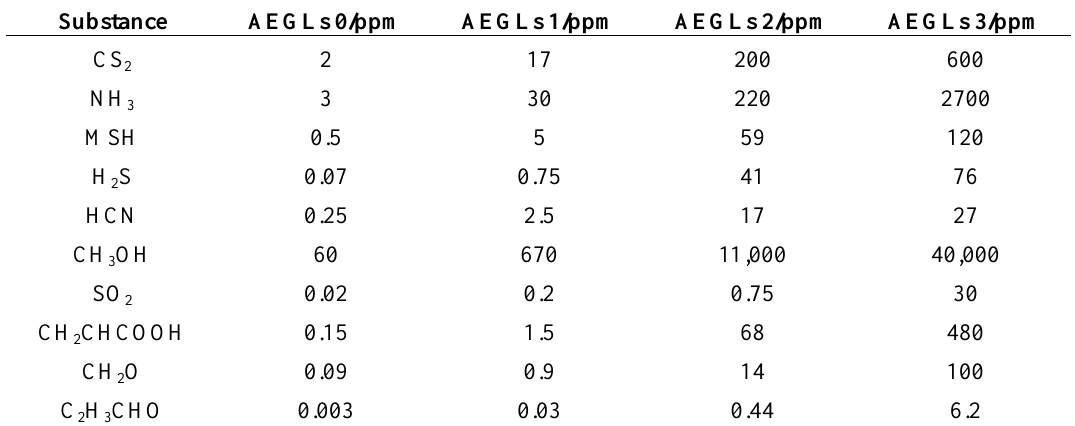
Table 5. The acute exposure guideline levels (AEGLs) threshold values of typical hazardous gas in the chemical